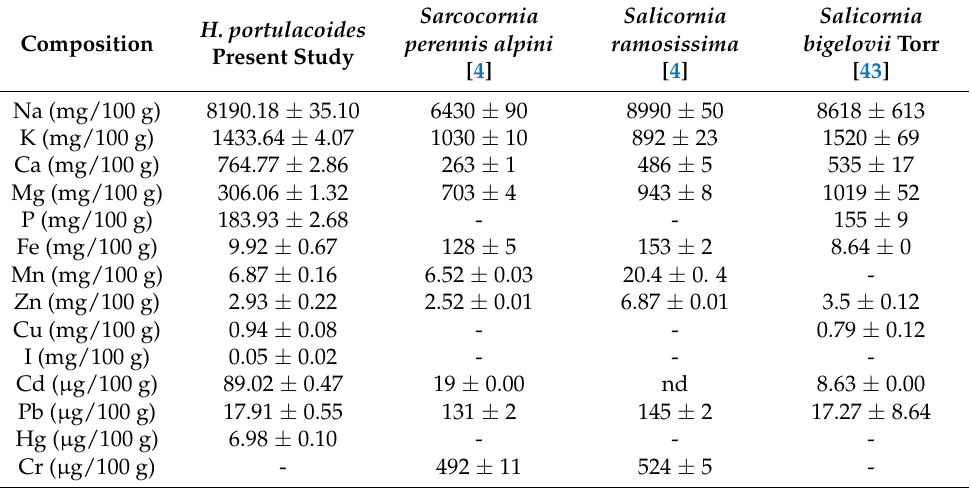
Table 3. Mineral composition (dry matter) of Halimione portulacoides and other halophyte plants. H. Composition